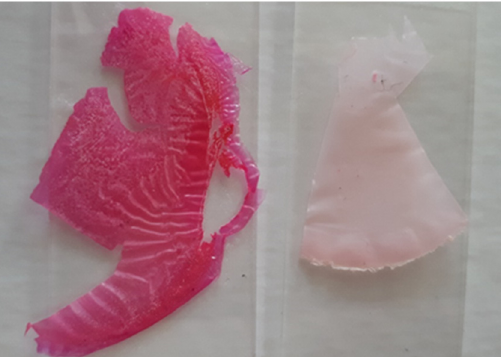
Figure 7. Modified chitosan hydrogel after a few weeks at room temperature: ( left ) chitosan membrane CS/Rh B ( left ) and CS/ NPs ( right ).